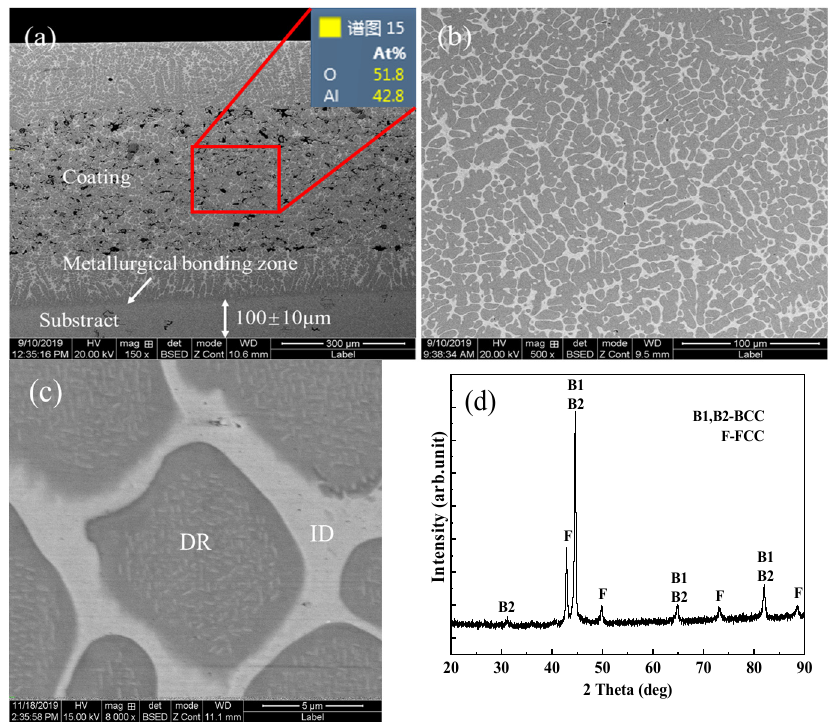
Figure 4. SEM images and XRD patterns of the FeCoCrAlCu HEA coating: ( a ) cross-section image, ( b ) coating surface at low magnification, ( c ) coating surface at high magnification, and ( d ) XRD pattern.